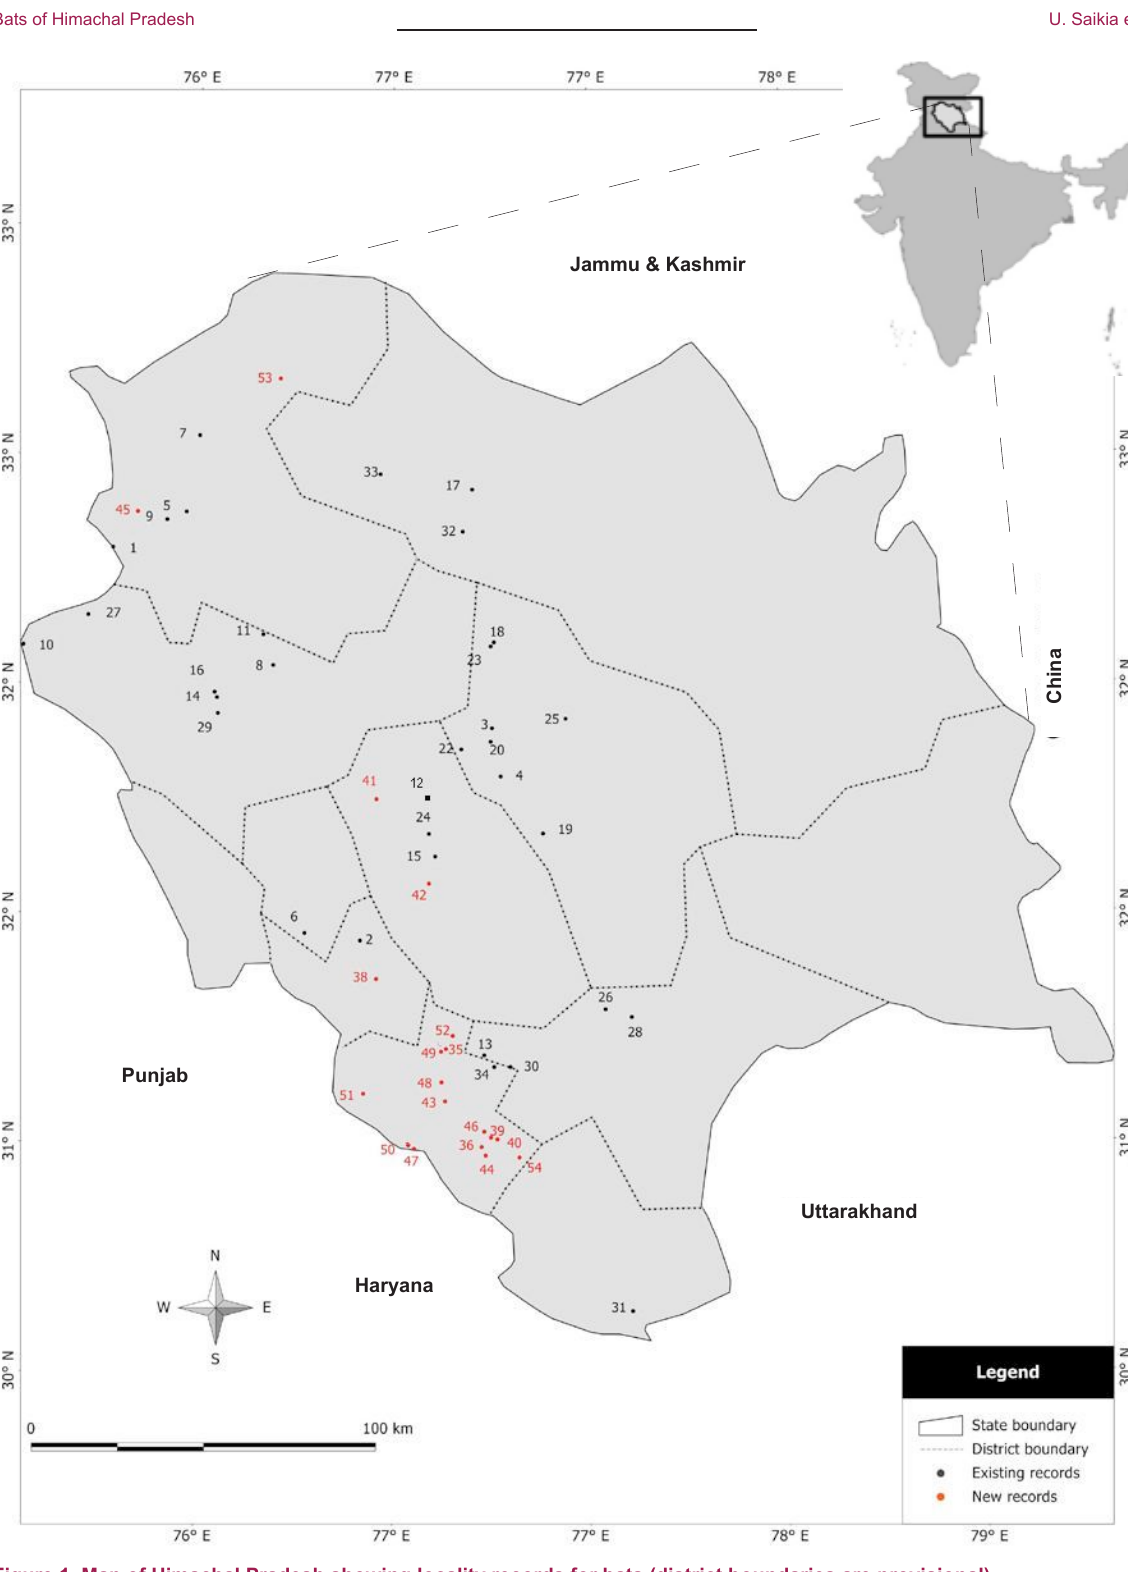
Figure 1. Map of Himachal Pradesh showing locality records for bats (district boundaries are provisional) 1 - Bakloh, 2 - Ballu at Ghumarwin, 3 - Bandrol, 4 - Bhunter, 5 - Chamba, 6 - Chakmoh, 7 - Chatri, 8 - Dadh, 9 - Dalhousie, 10 - Damtal, 11 - Dharamsala,12 - Drang, 13 - Ghanatti, 14 - Gopalpur, 15 - Gutkar, 16 - Kangra, 17 - Keylong, 18 - Kothi, 19 - Kotla, 20 - Kullu, 22 - Kullu Valley, 23 - Manali, 24 - Mandi, 25 - Manikaran, 26 - Narkanda, 27 - Nurpur, 28 - Ratandi in Baghi, 29 - Samayala, 30 - Shimla, 31 - Simbalbara, 32 - Sissu, 33 - Thirot, 34 - Tottu, 35 - Arki, 36 - Barog Tunnel,38 - Bilaspur, 39 - Brewery, 40 - Chambaghat, 41 - Dharampur, 42 - Dodour near Nehr Chowk, 43 - Gambhar, 44 - Happy valley, 45 - Kalatop, 46 - Karool hill, 47 - Kot Beja, 48 - Kunihar, 49 - Lutru cave, 50 - Majothu, 51 - Nalagarh, 52 - Shalaghat, 53 - Shaur, 54 -